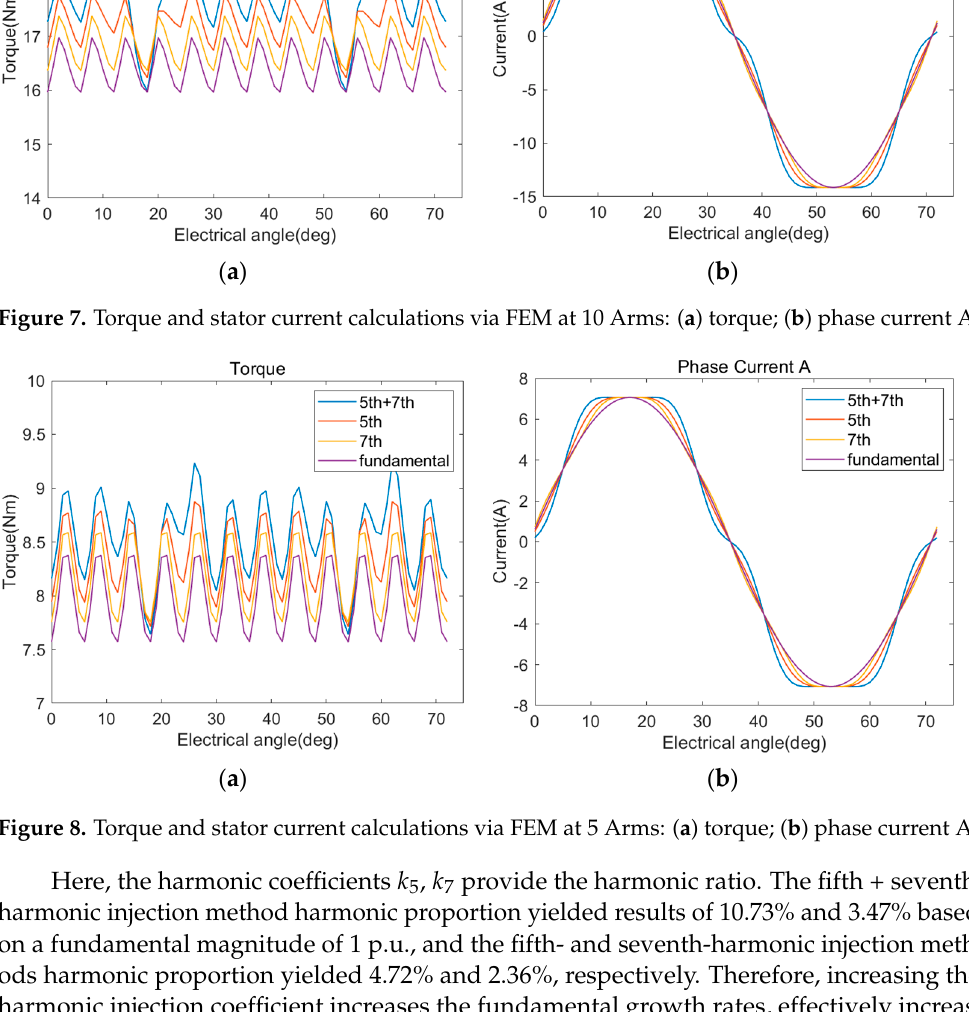
10.16% Here, the harmonic coefficients 𝑘 (cid:2873) , 𝑘 (cid:2875) provide the harmonic ratio. The fifth + sev- enth-harmonic injection method harmonic proportion yielded results of 10.73% and 3.47% based on a fundamental magnitude of 1 p.u., and the fifth- and seventh-harmonic injection methods harmonic proportion yielded 4.72% and 2.36%, respectively. Therefore, increas- ing the harmonic injection coefficient increases the fundamental growth rates, effectively increasing the average output torque, as well as increasing the torque ripple as a trade- off. The fifth-harmonic injection method had a 2.5% lower output torque growth rate com- pared to the fifth + seventh-harmonic injection method but decreased torque ripple by 5.28%. The fifth-harmonic injection method increased the output torque by nearly 5% compared to the fundamental control method. Both the fifth and seventh-harmonic injec- tion methods can be controlled via a PI controller by converting the injections into DC components using the Park transformation outlined in Equation (4). However, as the ro- tational speed of the motor increases, the control frequency must increase proportionally. The fifth-harmonic order is five times the fundamental frequency, and the seventh-har- monic order is seven times the fundamental frequency. For this reason, as the control fre- quency increases, the frequency of the seventh-harmonic components increases rapidly compared to the fifth-harmonic components, deviating from the current control band- width. Therefore, since the fifth-harmonic components are lower second order compared to the seventh-harmonic components, the current control band can be secured stably. The current RMS values increased by 4.7%, and 2% based on the fundamental control method for the fifth- and seventh-harmonic injection methods, respectively. The average torque for each injection method based on the fundamental control method increased by 5%, and 2.4%, respectively, under the 10 Arms condition. The fundamental growth rate of the fifth- harmonic injection method can then be doubled compared to that of the seventh-harmonic